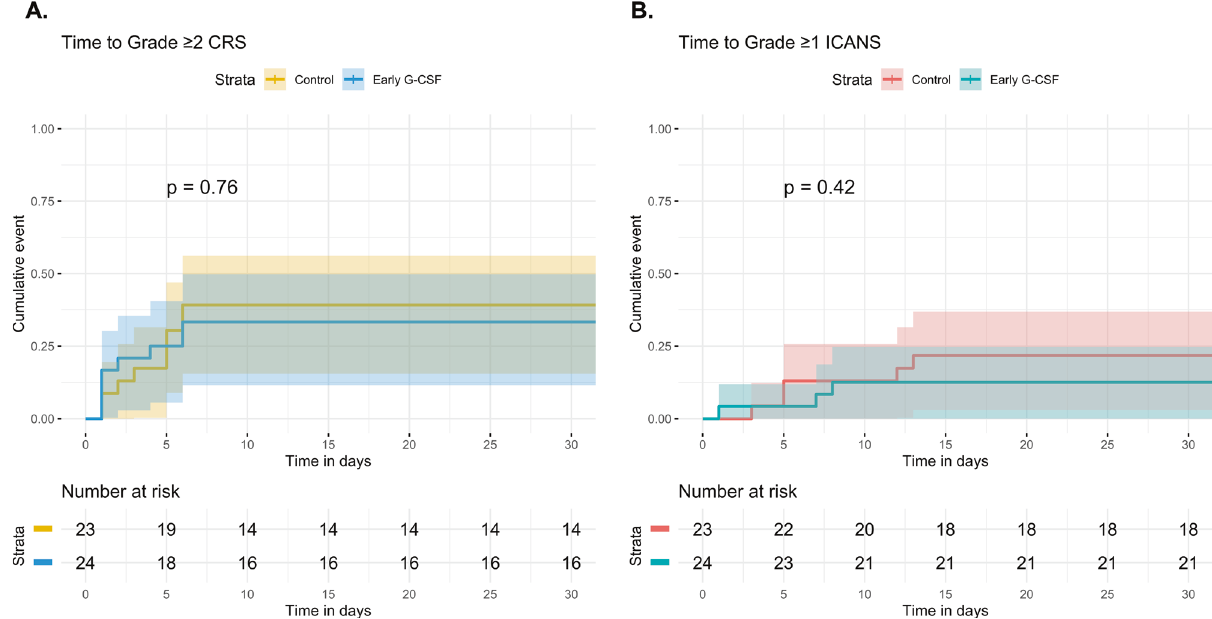
Fig. 5 Cumulative incidence of CRS and ICANS in multiple myeloma patients treated with anti-BCMA CAR T cells. Time to grade ≥ 2 CRS ( A ) and grade ≥ 1 ICANS ( B ) were estimated and compared by method of Gray, strati fi ed by early G-CSF administration. The early G-CSF group ( N = 24) received G-CSF within ≤ 2 days after CAR T, whereas the control group ( N = 23) either received G-CSF ≥ 3 days after CAR T or were not exposed to G-CSF. 95% con fi dence intervals are represented by